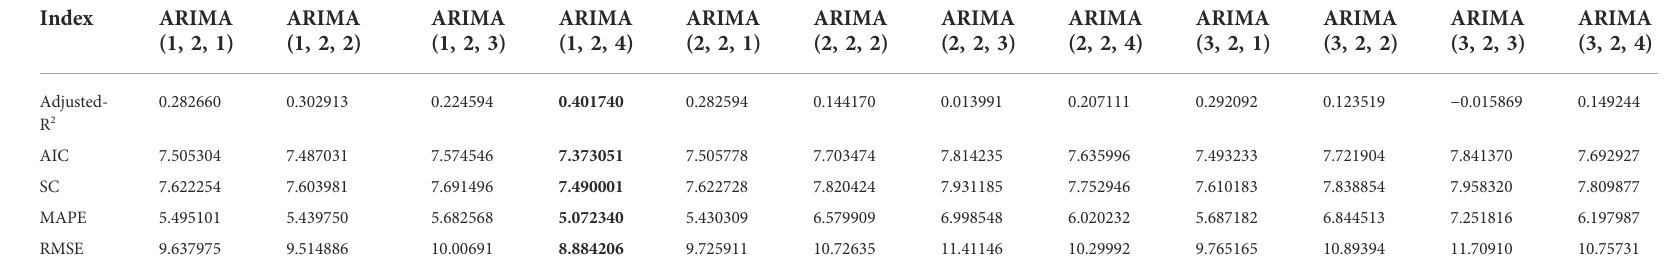
TABLE 6 The parameter comparison of each model ’ s test index (eliminate seasonal fl